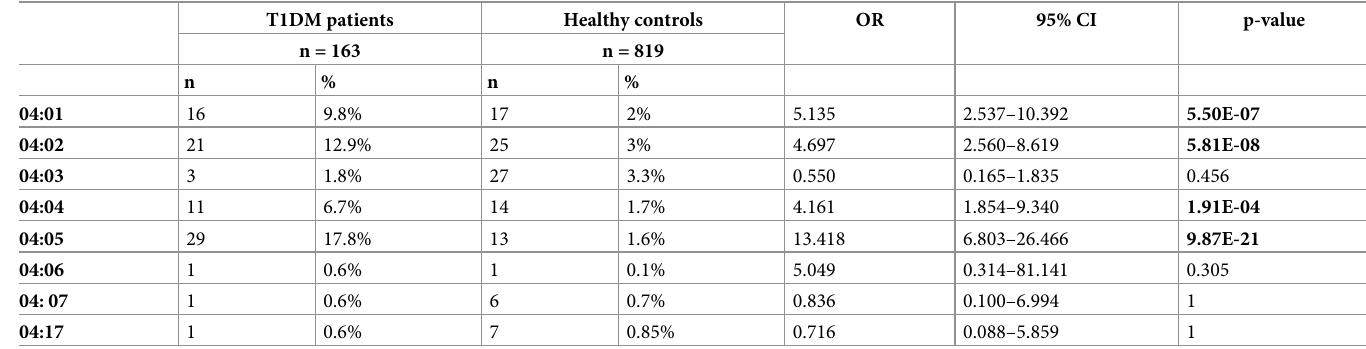
Table 2. Comparison of the DRB1 � 04 allelic variants of the study and control populations. The allele variants with significant p values are in bold. T1DM patients Healthy controls OR 95% CI